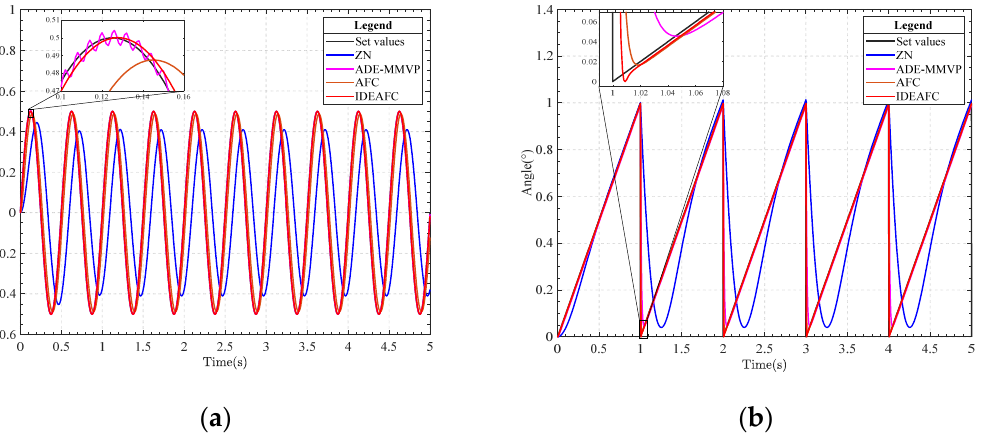
Figure 9. ( a ) Comparison curve of sine signal response of location ring; ( b ) comparison curve of sawtooth wave response of location ring.